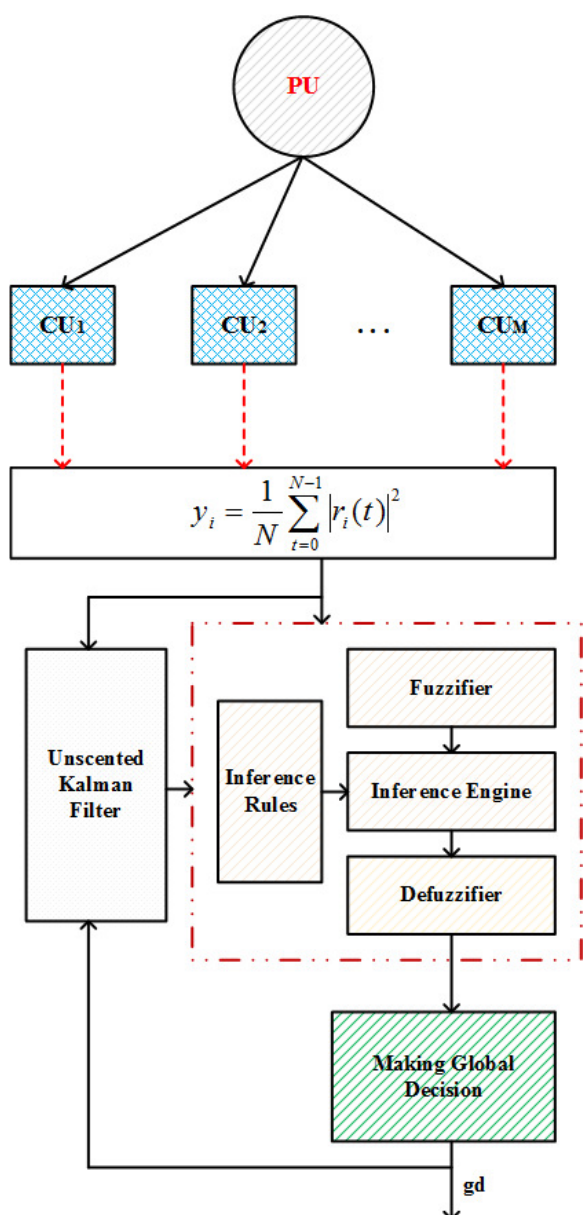
Figure 4. The proposed unscented Kalman filter (UKF) based on cooperative spectrum sensing (CSS) in a cognitive radio network (CRN) using an adaptive fuzzy